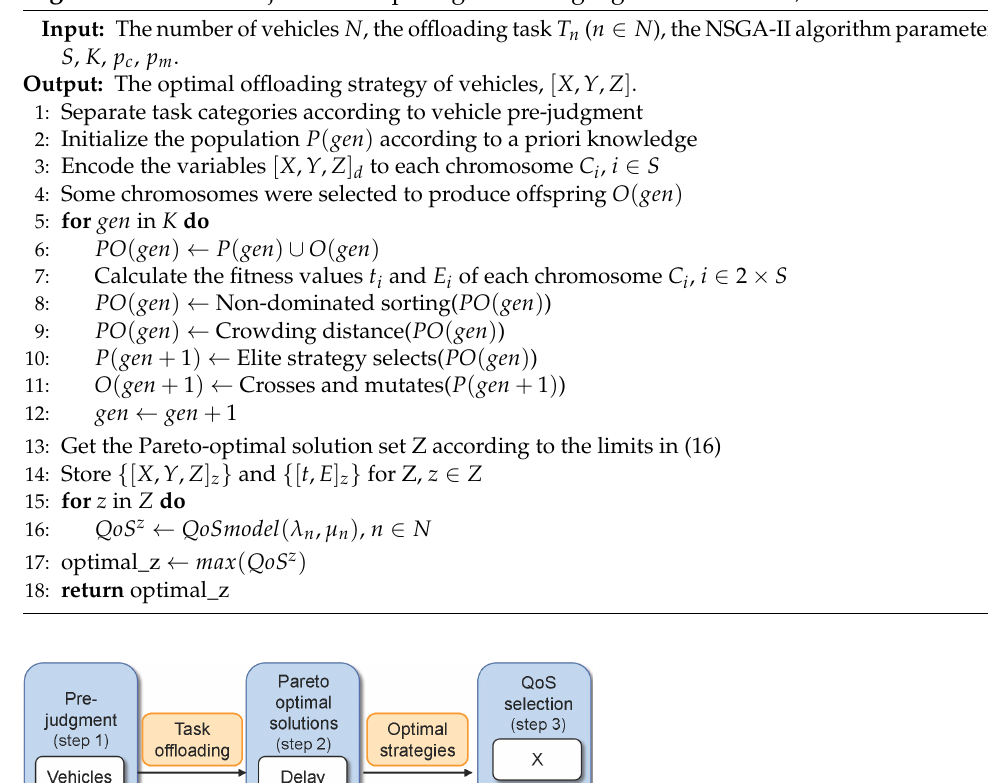
Algorithm 1 Multi-Objective computing offloading algorithm for VEC, MOV